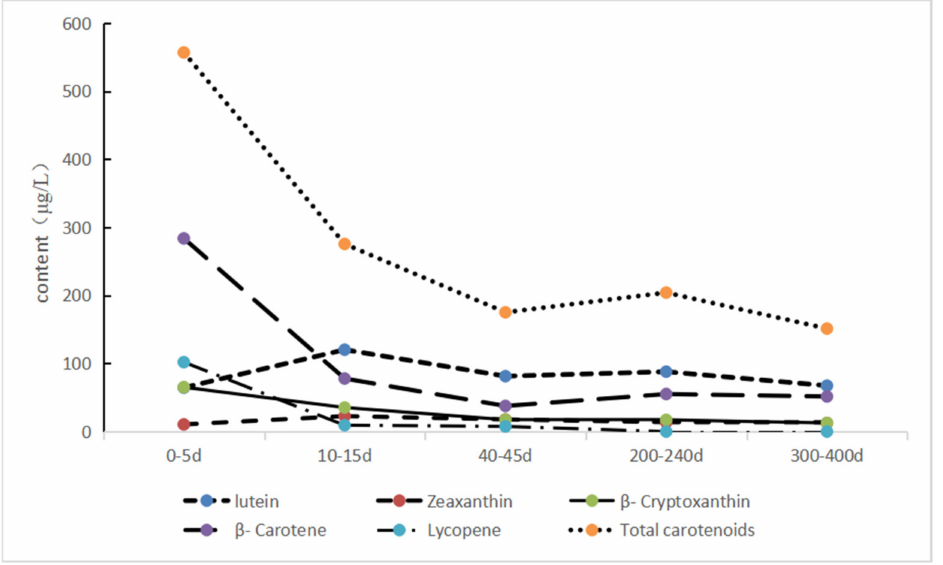
Figure 2. Trends of the content of carotenoid in five lactation stages milk in the Guangzhou area ( µ